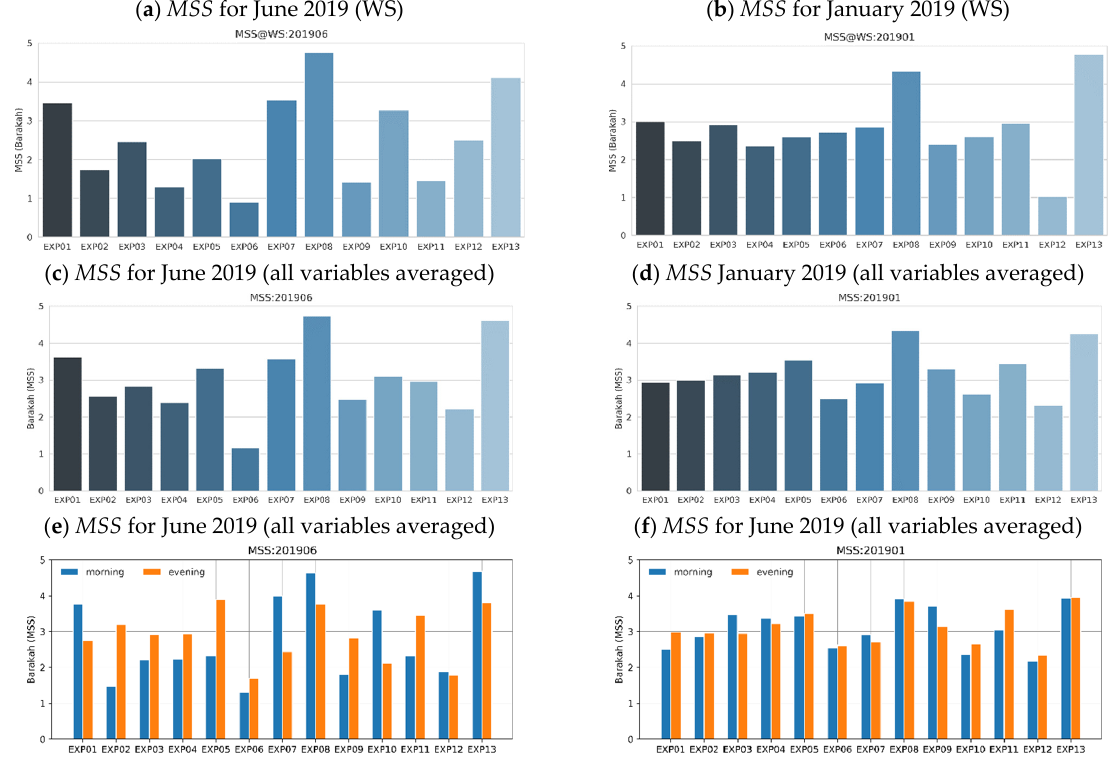
Figure 12. Model Skill Scores ( MSS ) at Barakah calculated for June and January 2019.